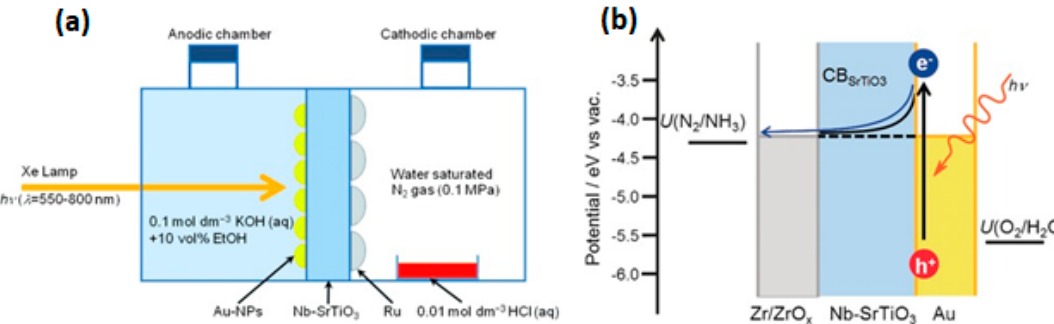
Figure 15. ( a ) A schematic illustration of the NH 3 synthesis device using a Nb-SrTiO 3 photoelectrode loaded with Au nanoparticles [80]; ( b ) Energy level diagram of the plasmon-induced NH 3 synthesis device [81]. (Reproduced with permission from the respective publishers).